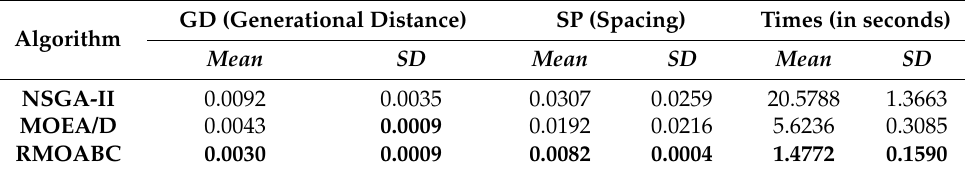
Table 6. Results of the performance metrics for UF2 function of the algorithms.